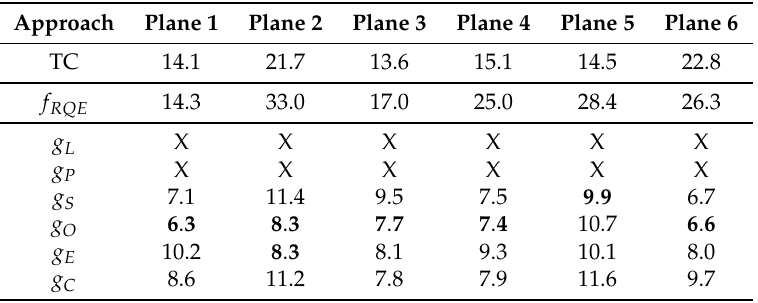
Table 2. Mean point-to-plane distances for different parts of the point cloud (in mm). X: Calibration failed. The smallest point-to-plane distance in each column is marked in bold. Again, all self-calibrations except for g L and g P achieve better results than the TC and the calibration based on RQE . For five of the six planes, the omnivariance g O achieves the lowest mean distances.